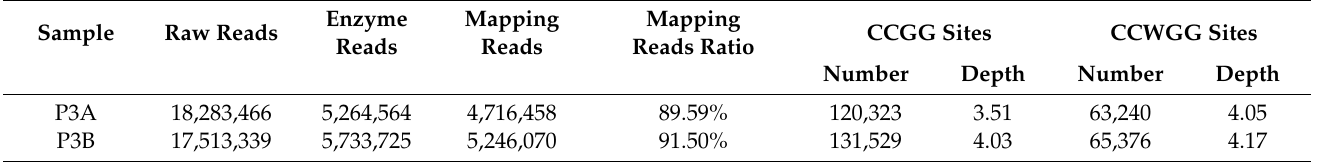
Table 1. Summary of sequencing quantity and methylation site coverage.